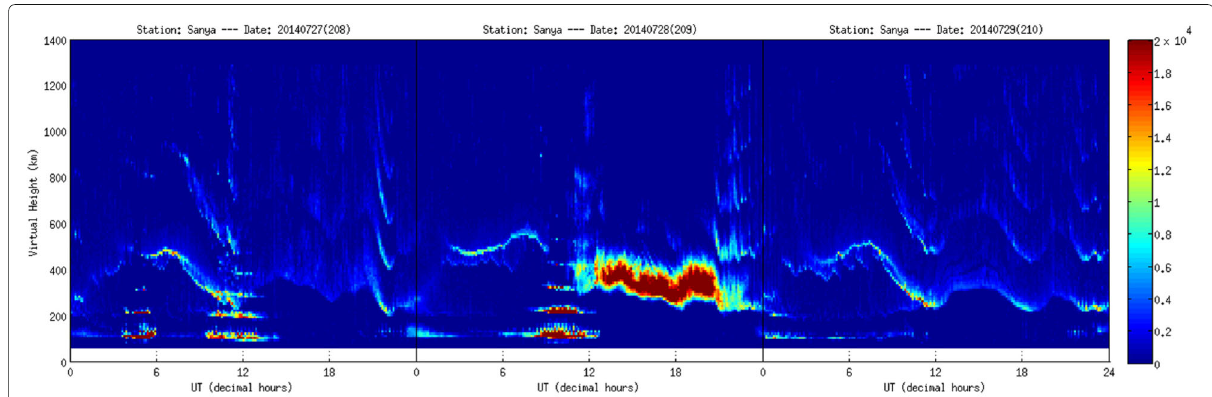
Fig. 5 Range-time-intensity-style plot of ionospheric echoes received from the Sanya ionosonde during 27–29 July 2014. Ionograms collected every 15 min were used to generate this figure. The color scale indicates the number of echoes across all sounding frequencies